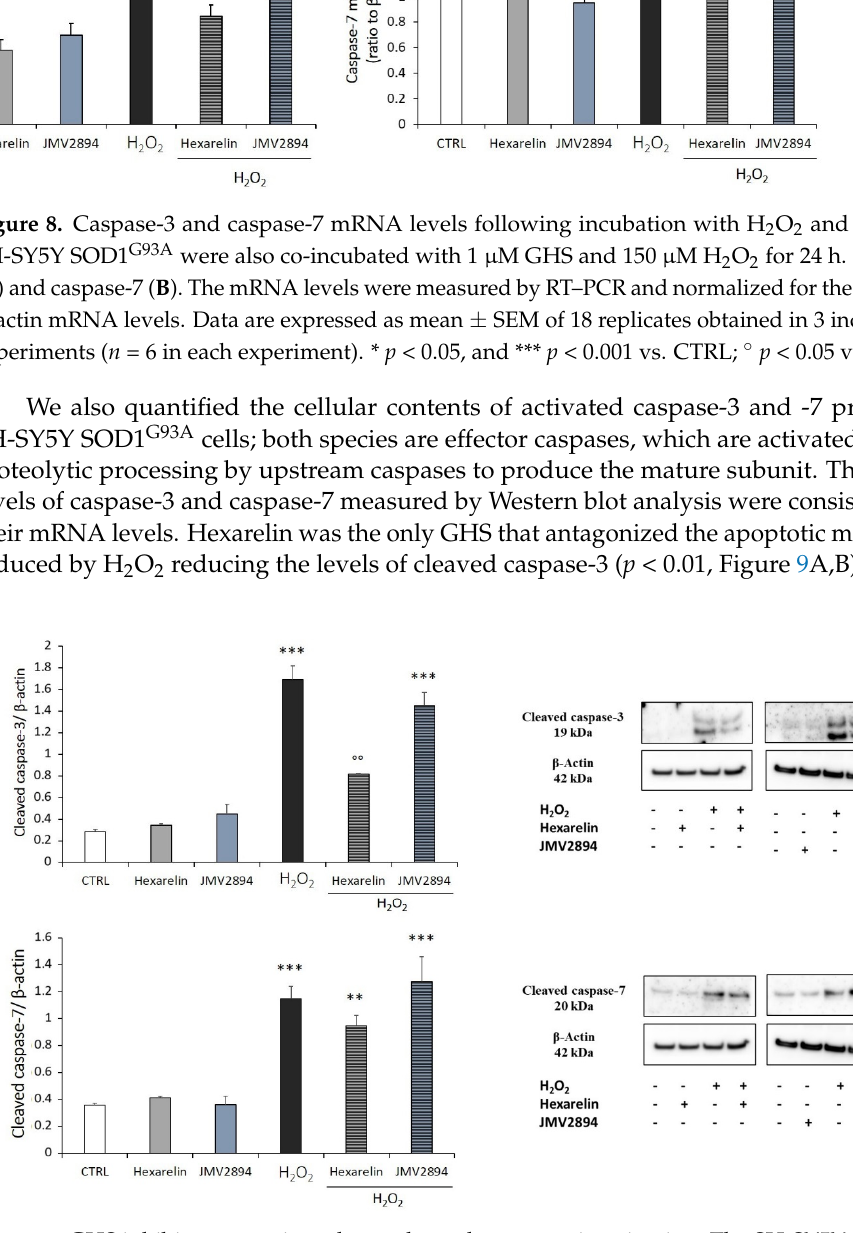
Figure 7. Caspase-3 and caspase-7 mRNA levels following incubation with increasing concentrations of H 2 O 2 . SH-SY5Y WT and SOD1 G93A cells were incubated with different